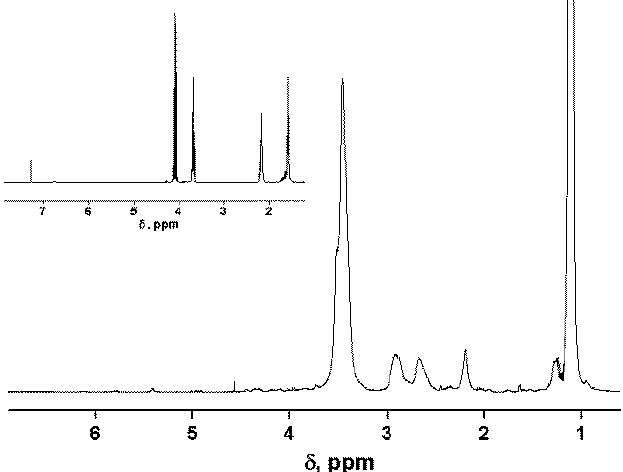
Figure 1 . 1 H NMR-spectra of cross-linked PiPrOx. Inset: 1 H NMR-spectra of bis-oxazoline. Figure 1. 1 H NMR-spectra of cross-linked PiPrOx. Inset: 1 H NMR-spectra of